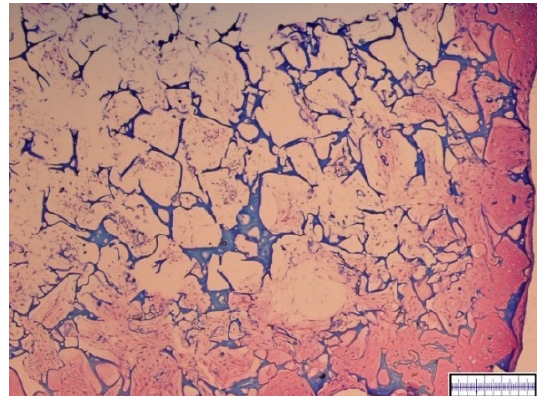
Figure 5. Representative histological slide of a hyaluronic acid gelatin composite scaffold after 21 days of in vitro chondrogenesis with visible central necrosis. DMMB staining. Proteoglycan-rich extracellular matrix appears red, scaffold parts appear blue. Magnification bar = 500 µ m.